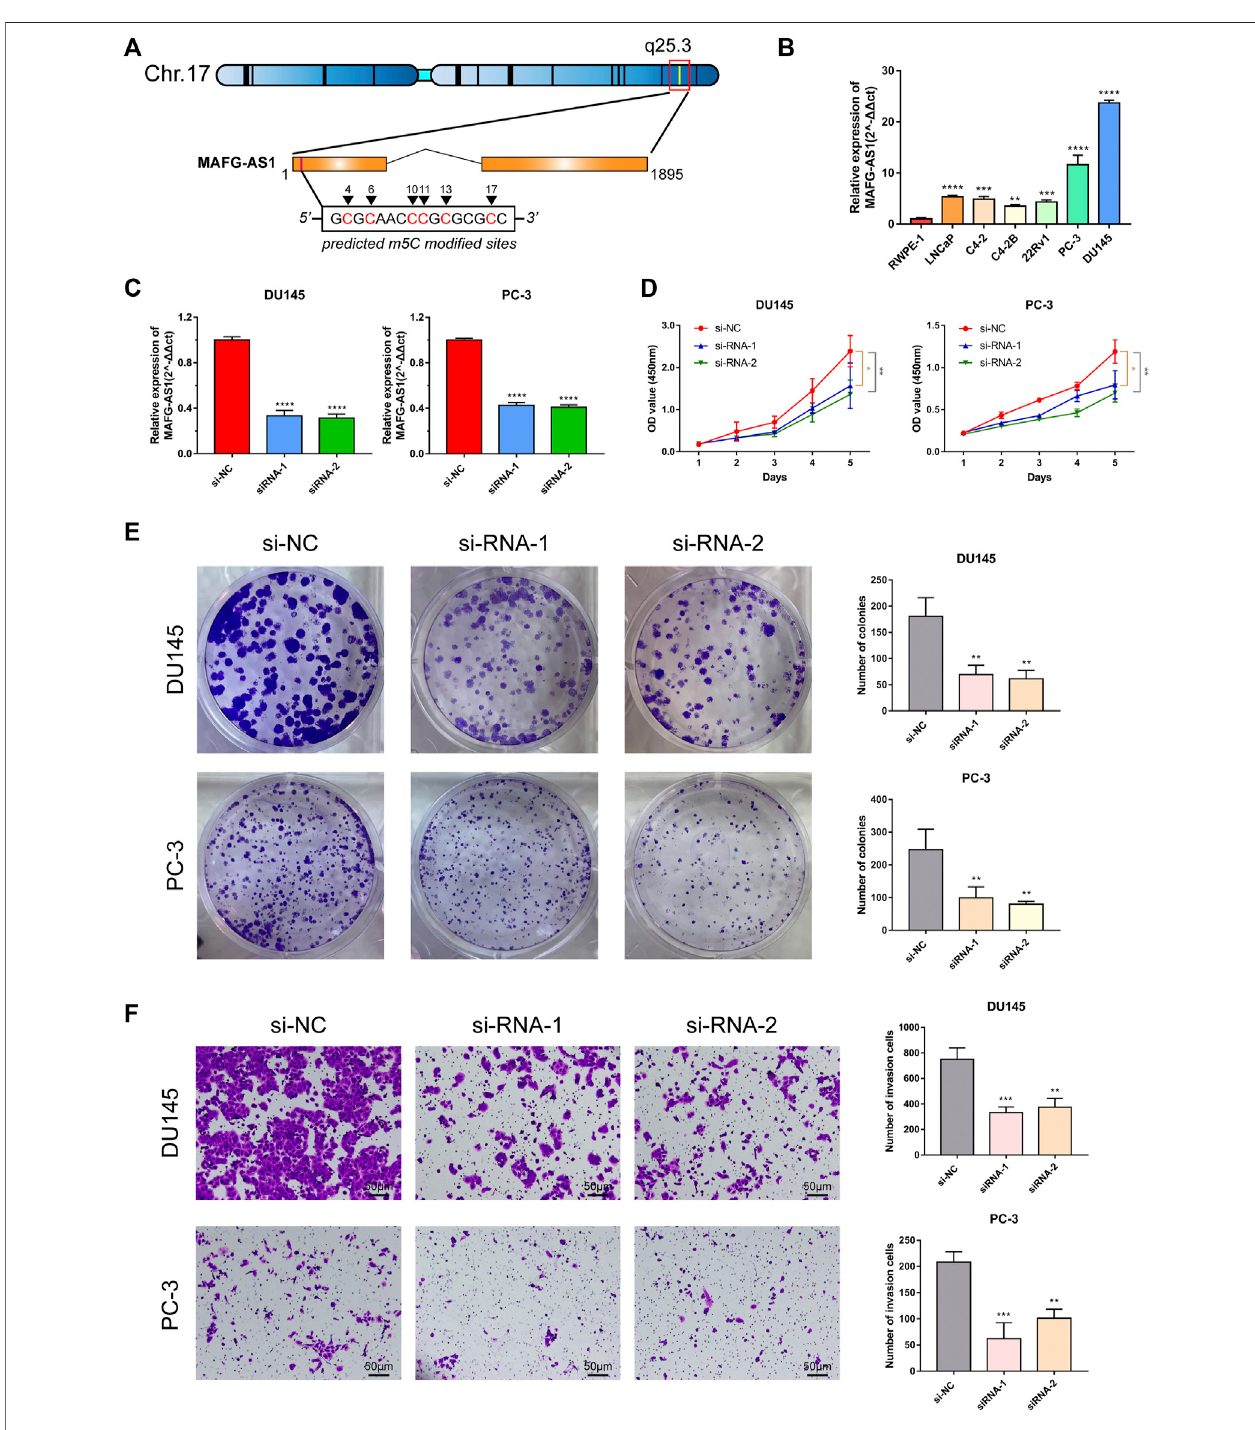
FIGURE6| CharacteristicsofMAFG-AS1anditsfunctionaleffectonPCa. (A) Thebasicinformationof MAFG-AS1 anditsm5Csitespredictedbythewebsitetool, iRNAm5C-PseDNC. (B) Basal expression level of MAFG-AS1 inPCa cell lines. (C) RT-PCR veri fi ed thetransfection ef fi ciency ofsiRNAs targeting to MAFG-AS1 inPC-3 andDU145. (D) CCK-8assayrevealedthatknockdownof MAFG-AS1 inhibitedPCacellsviability. (E) Knockdownof MAFG-AS1 inhibitedcolonyformationinPCacells. (F) Knockdown of MAFG-AS1 attenuated PCa cells ’ invasive ability. Error bar indicates mean ± SD. * p < 0.05, ** p < 0.01, and *** p < 0.001, **** p < 0.0001.